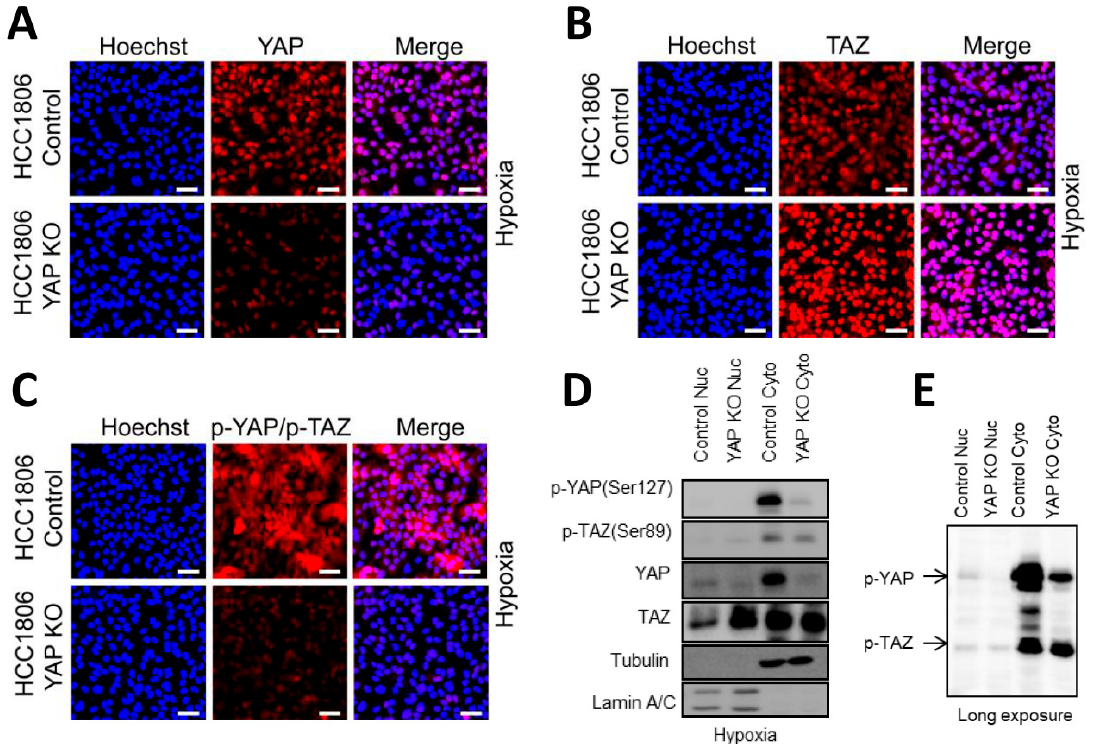
Figure 6. Localization of TAZ and phosphorylated YAP/TAZ in luminal breast cancer and basal A cells under normoxia and hypoxia. ( A ) Localization of TAZ and p-YAP/TAZ (using an Ab detecting both p-YAP(Ser127) and p-TAZ (Ser89)) determined by confocal immune fluorescence microscopy in luminal (MCF7, T47D and BT474) and basal A (SUM149PT, HCC1806 and HCC1143) breast cancer cell lines cultured under normoxia (NX) or hypoxia (HX) for 5 days. Blue, Hoechst; Red, Abs. ( B , C ) Quantification of nuclear/cytoplasmic distribution of TAZ and p-YAP/TAZ in luminal ( B ) and basal A cells ( C ) cultured under normoxia or hypoxia, calculated form images in ( A ). Y-axis indicates percentage of the total intensity in the nuclei area versus percentage of the total intensity in the cytoplasm area. *, p < 0.05; **, p < 0.01; ***, p < 0.001; ns, not significant.